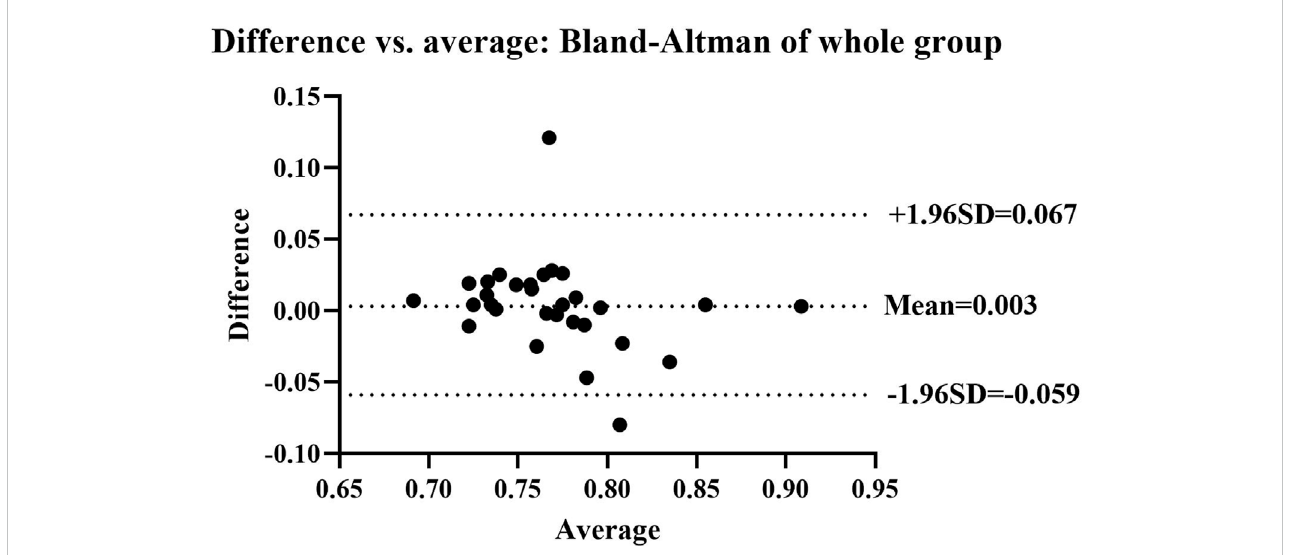
Bland-Altman plot showing agreement between the fi rst and second AIDAW tests of the whole group. The mean difference score was 0.003, and the 95% limits of agreement were at − 0.059 and 0.067. Two points fall beyond the 95%